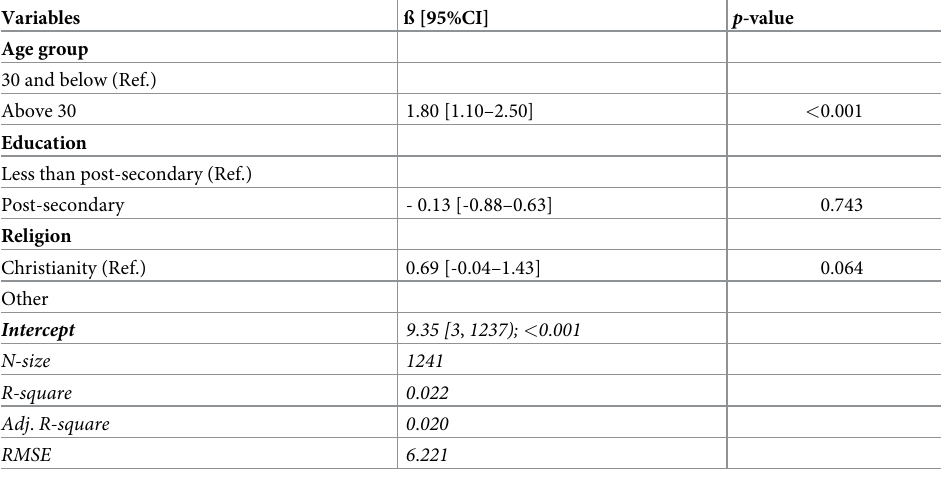
Table 4. Linear regression model showing predictors of clients’ satisfaction with RMNCH services during the COVID-19 outbreak in Lagos. Variables